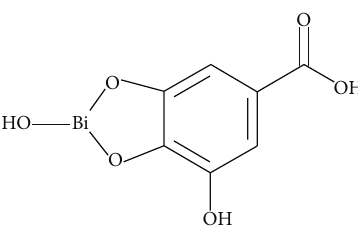
Figure 1: Chemical structure of bismuth subgallate [19].